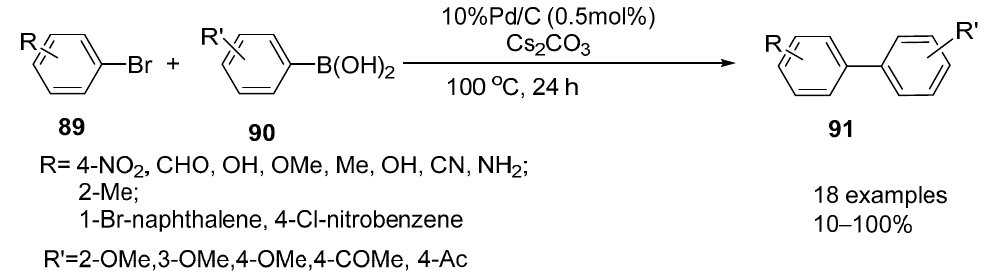
Scheme 15. Solvent-free Pd/C-catalyzed synthesis of biphenyls.